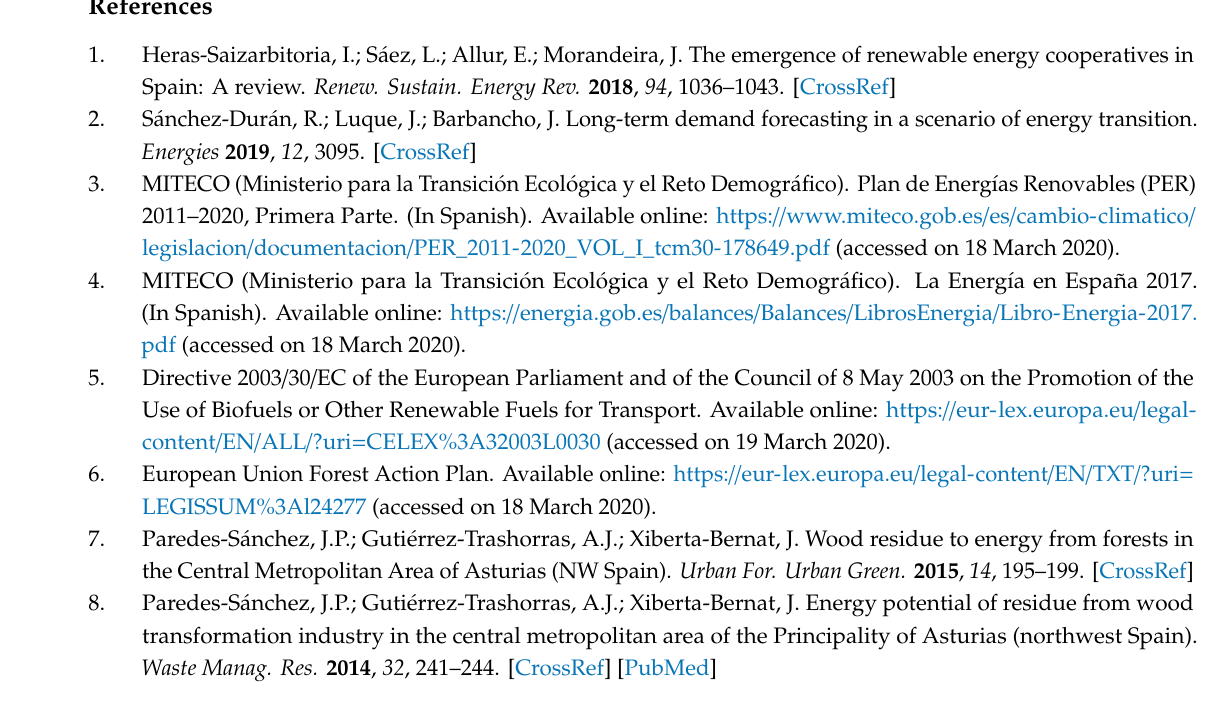
algorithm based on operational resource data, thermo-energetic conversion, and energy management has been